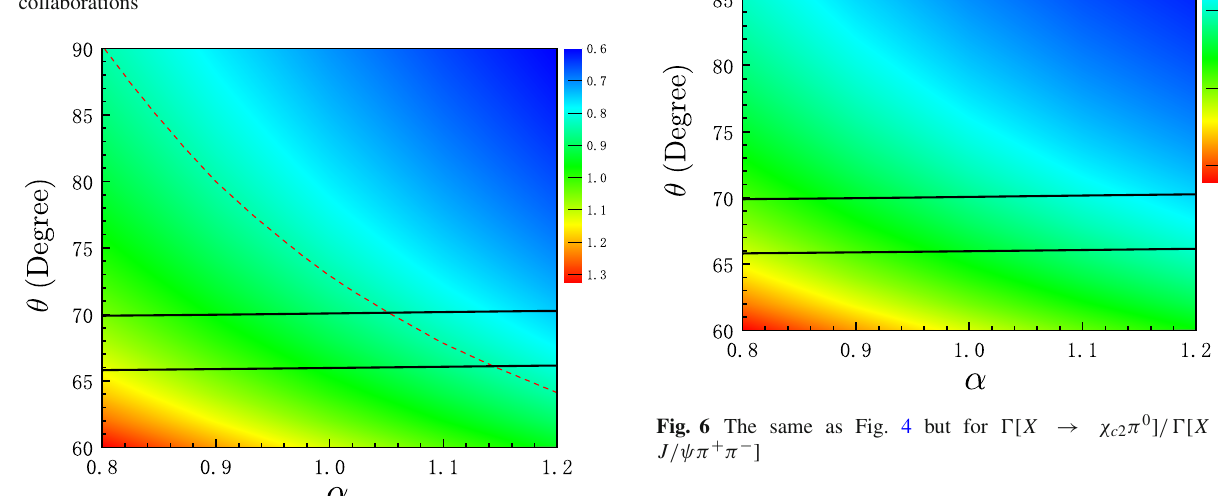
Fig. 3 The ratio (cid:5) [ X → J /ψπ + π − π 0 ] /(cid:5) [ X → J /ψπ + π − ] depending on the parameter θ and α . The black solid lines are the upper and lower limit from the BESIII measurements, while the dashed lines are the upper and lower limits determined by BABAR and Belle collaborations